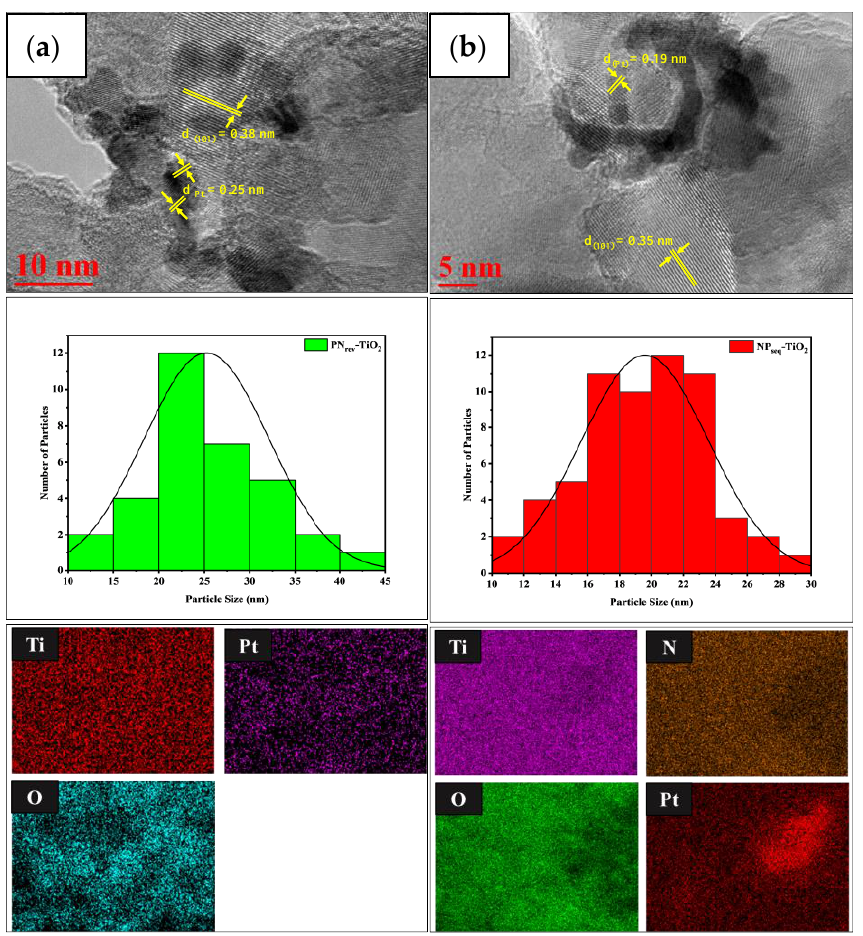
Figure 6. The HR-TEM image, average particle size, and mapping analysis for ( a ) NP seq -TiO 2 and ( b ) PN rev -TiO 2 photocatalysts.